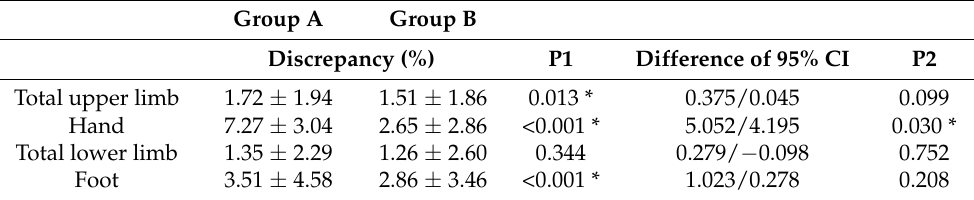
Table 3. Correlation of limb length discrepancy (%) with DTI parameters and with the degree of CST disruption. Correlation Coefficient (r) FA MD Degree of CST Disruption Total upper limb − 0.065 0.096 −